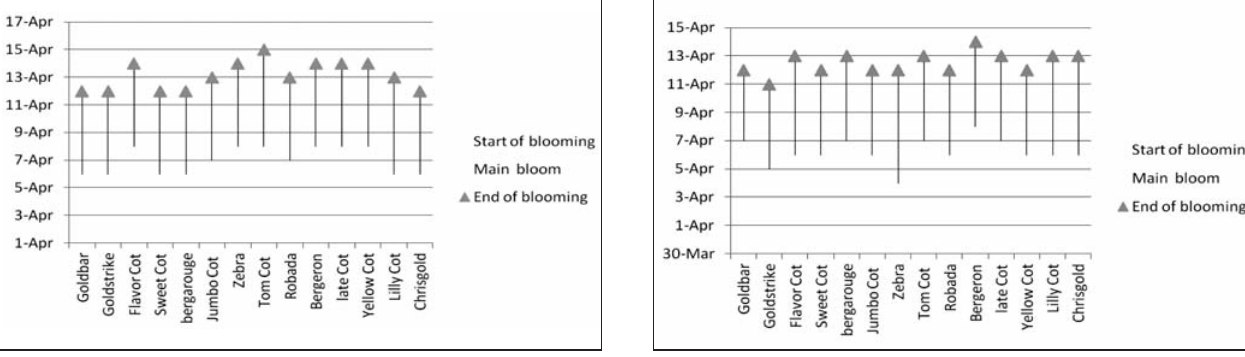
Fig 3: Time of start, main and end of blooming 14 apricot varieties through 2011 seasons